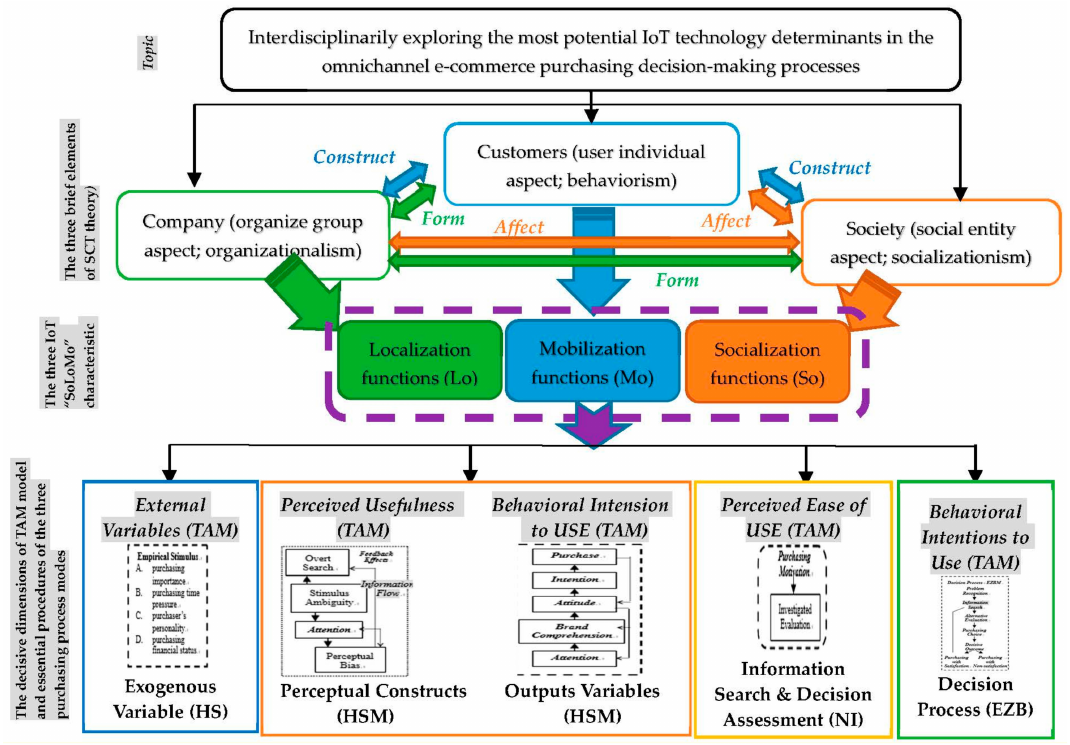
Figure 6. Brief analytical